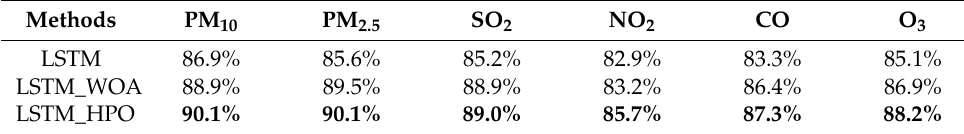
Table 16. The accuracies of the LSTM_HPO compared with LSTM and LSTM_WOA in dataset 3. Methods